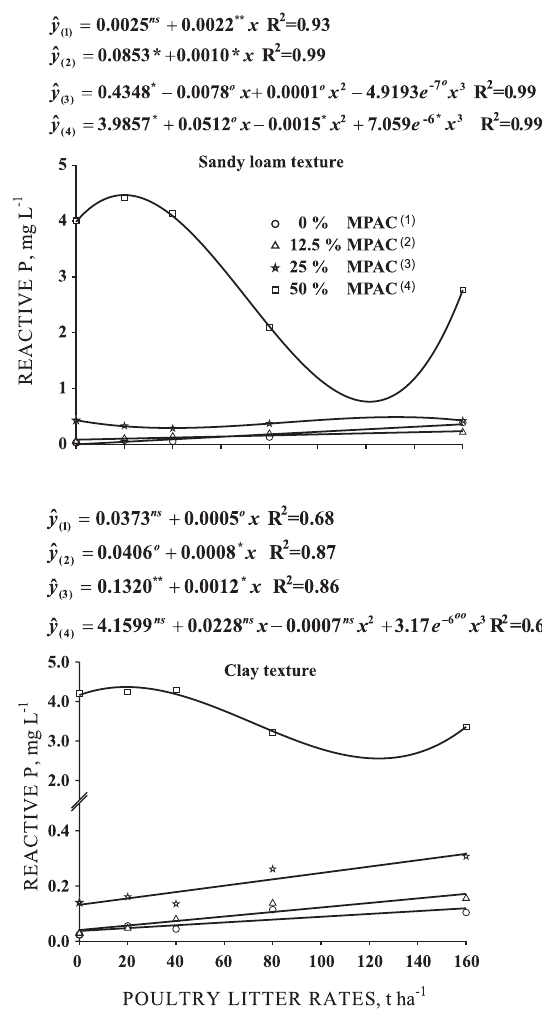
Figure 1. Concentrations of reactive P (Pi) in leachate collected from two Latosols of sandy loam and clay texture, prefertilized with increasing rates of mineral P, as related with the poultry litter rates applied in the top ring. ns , oo , o , *, **: not significant and significant at 15, 10, 5 and 1 %, respectively.